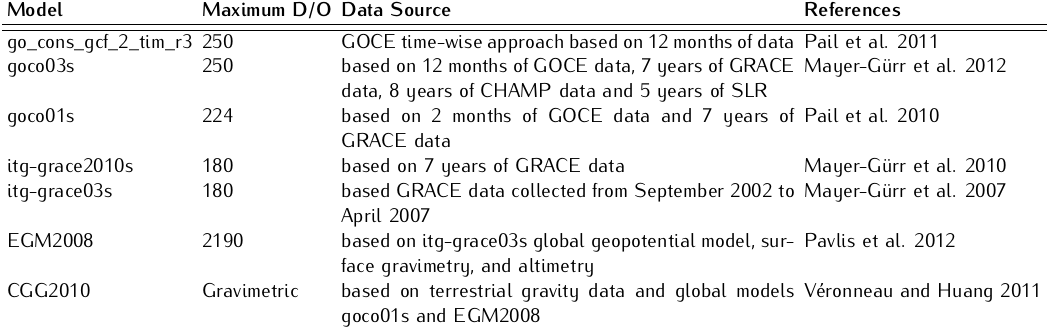
Table 1. Global geopotential models, regional geoid models, and their supporting background models utilized for the evaluation of LVD offsets.